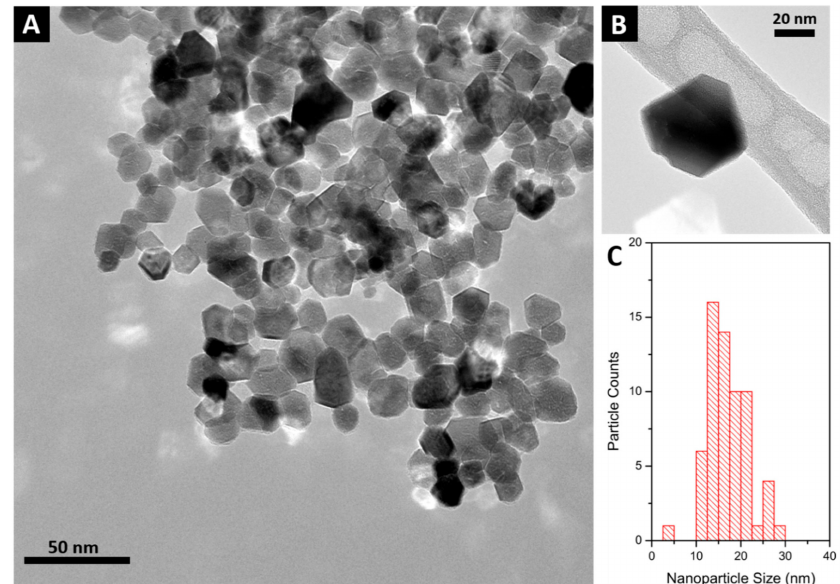
Figure 1. ( A ) Representative TEM image of CeO 2 nanoparticles (NPs) synthesized in synthetic sweat at